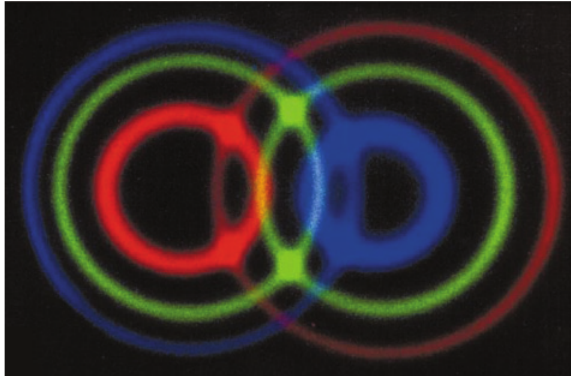
Figure 7: Several cone pairs can be seen along the direction of the optical axis. The pairs of photon emitted along the cone intersections are entan- gled in polarization